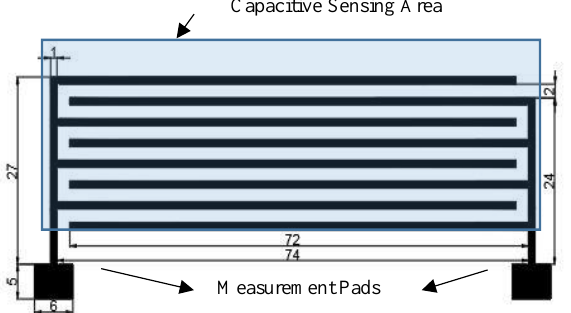
Figure 1 . Layout and dimension detail of the proposed moisture sensor (in mm). The bottom squares correspond to the characterization pads, and the capacitive sensing area corresponds to the interdigitated area.